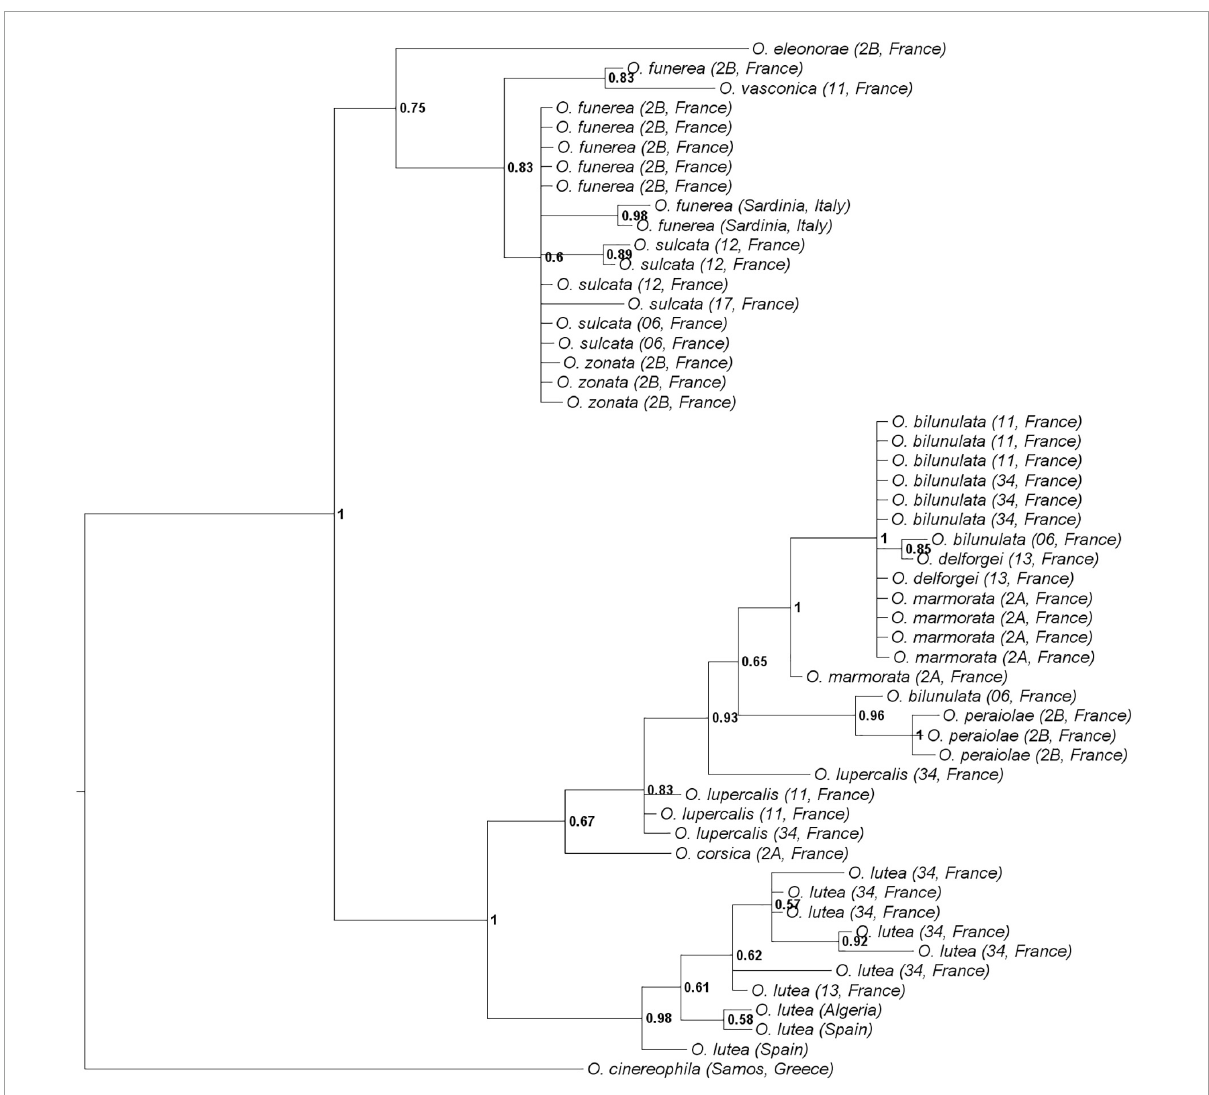
FIGURE2 Phylogenetic relationships between the twelve French Pseudophrys taxa represented by the 50-majority rule consensus tree from the MrBayes analysis. Posterior probabilities are indicated at each node.